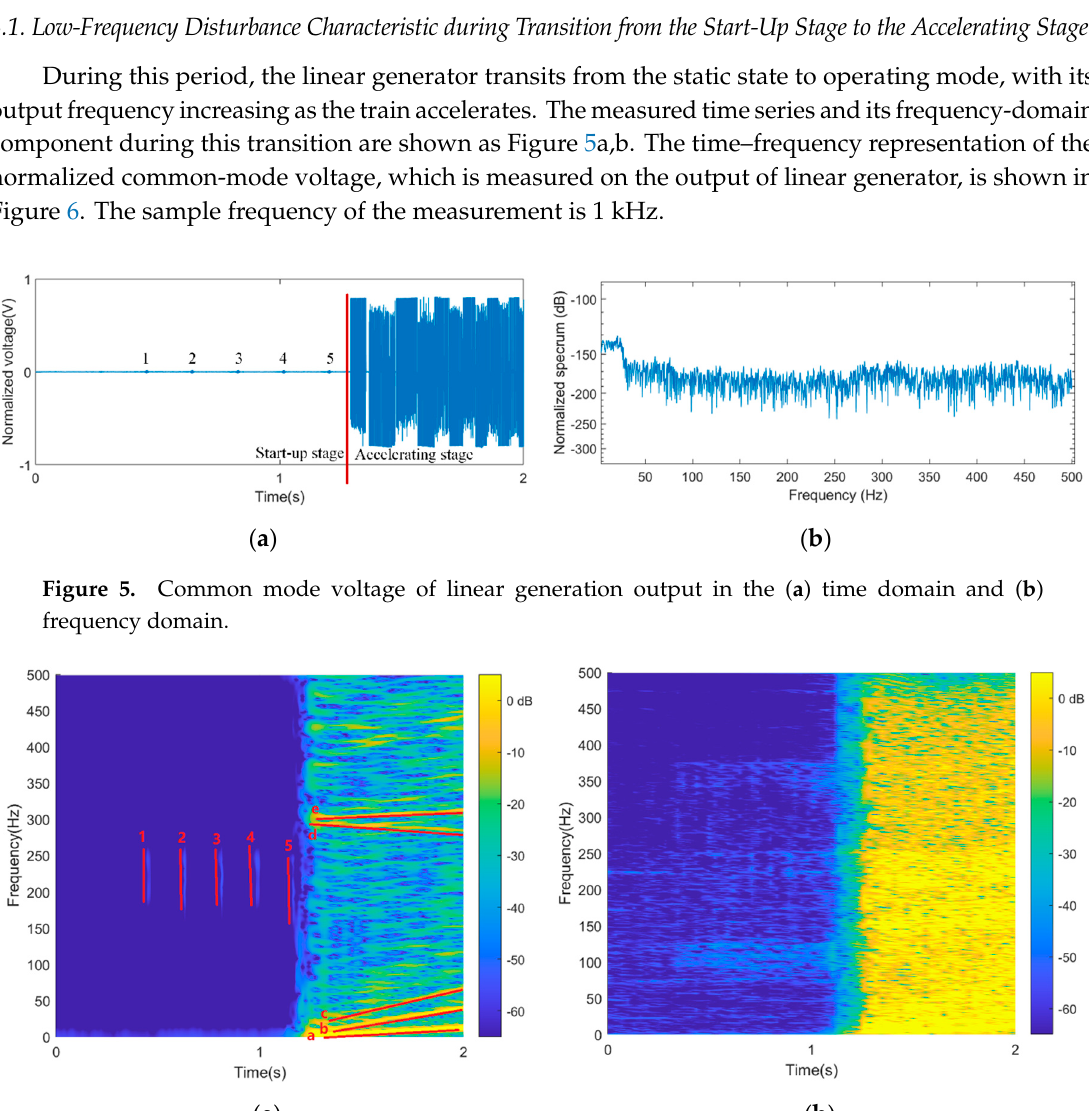
Figure 6. Time–frequency spectrogram of common-mode voltage of the linear generator represented by ( a ) joint TF and ( b ) WVD.